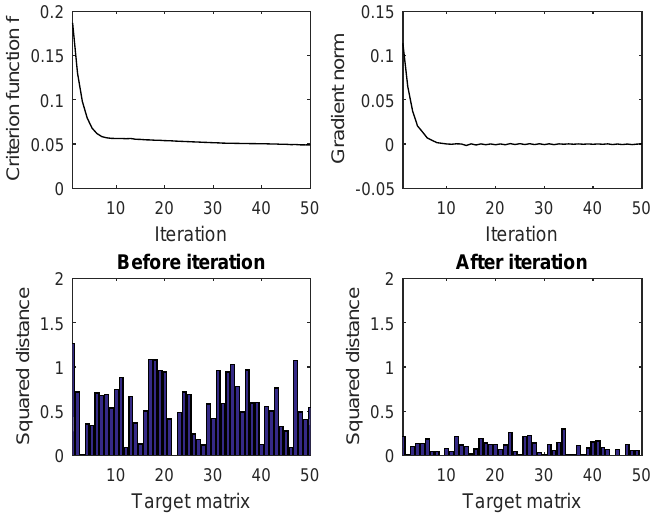
Figure 10. Mean-matrix computation over the pseudo-orthogonal group O ( 5,5 ) : Values of the criterion function in Equation (38) during iteration, of the pseudo-norm of its pseudo-Riemannian gradient, of the distances D g ( X , X k ) before iteration ( X = X ( 0 ) ) and after iteration ( X = µ )